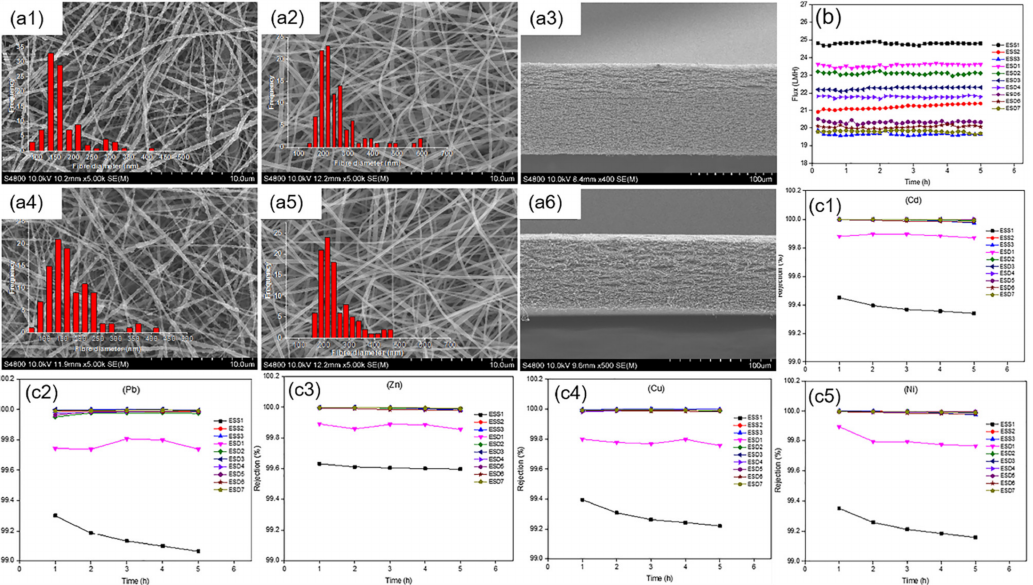
Figure 4. ( a ) SEM images for the top layer ( a1 , a4 ), bottom layer ( a2 , a5 ), and cross-section ( a3 , a6 )